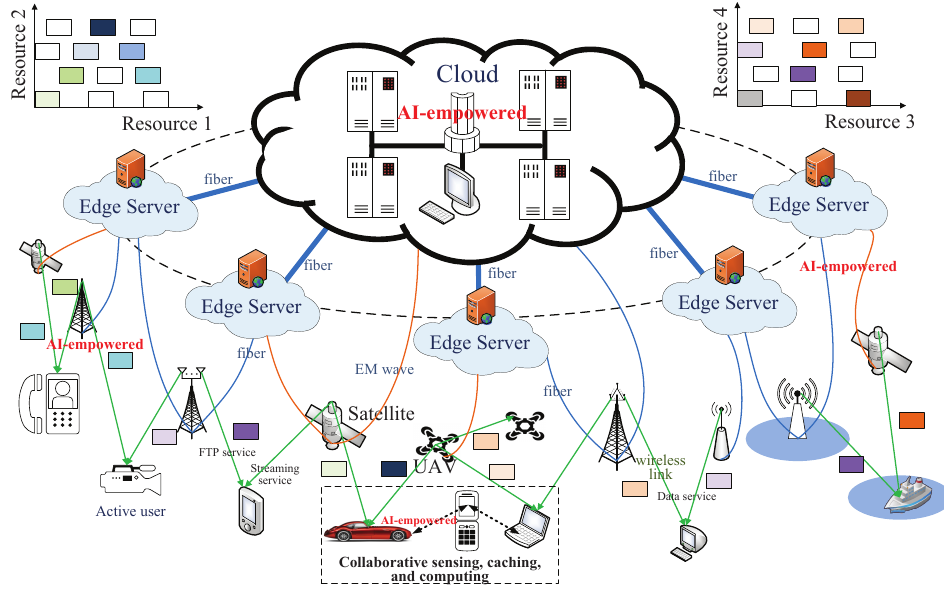
Figure 3. Intelligent cloud architecture for the 6G